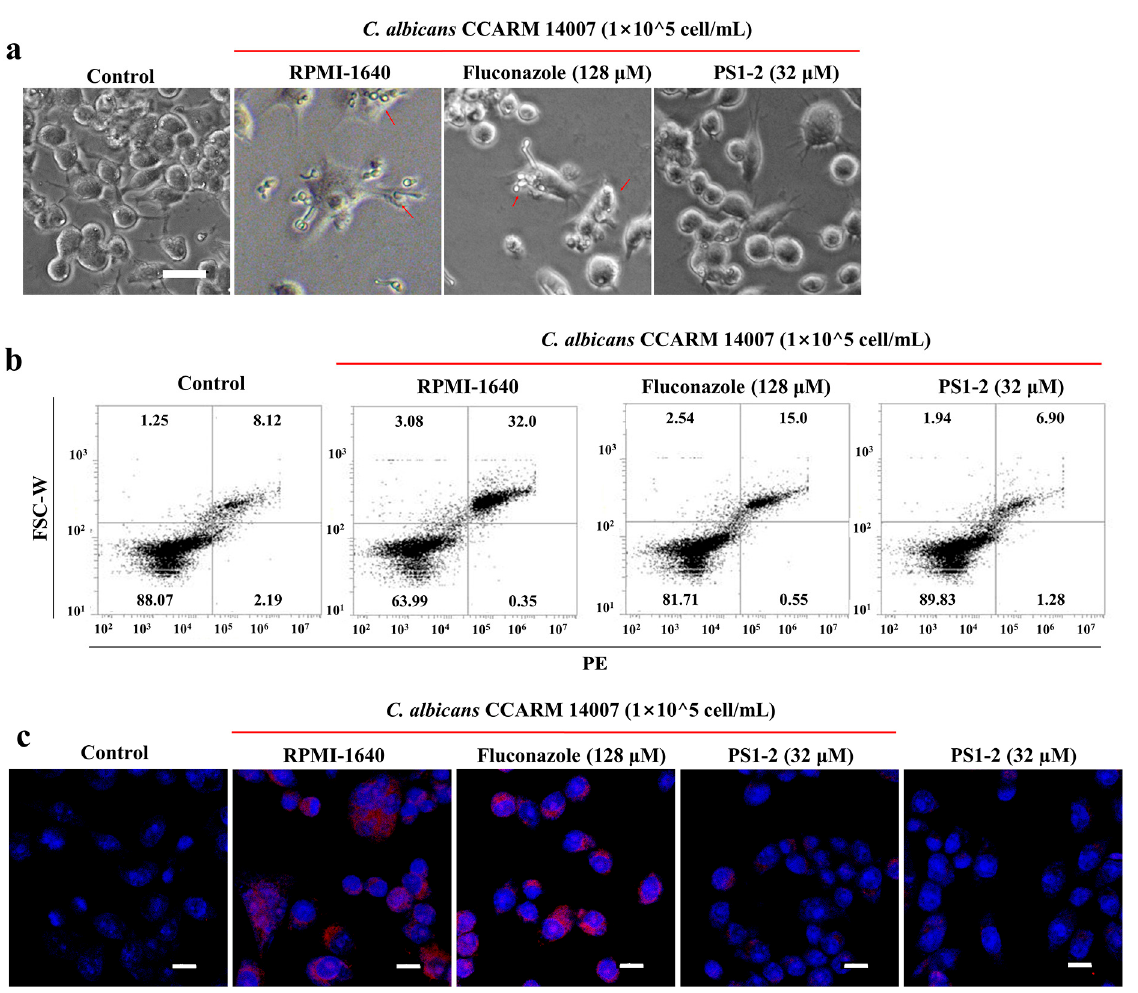
Figure 5. Anti-inflammatory effects of fluconazole and PS1-2. ( a ) Pre-cultured RAW 264.7 cells were stimulated with C. albicans CCARM 14007 in the presence or absence of fluconazole (128 µM) and PS1-2 (32 µM), followed by 24 h incubation. Arrow indicates phagocytosis. ( b ) TLR-2 expression on the surface of RAW 264.7 cells was analyzed using flow cytometry. ( c ) TNF- α over-expression in RAW 264.7 cells was visualized under confocal laser scanning microscope (CLSM). Size bar is 20 µm ( a ) and 10 µm ( c ).